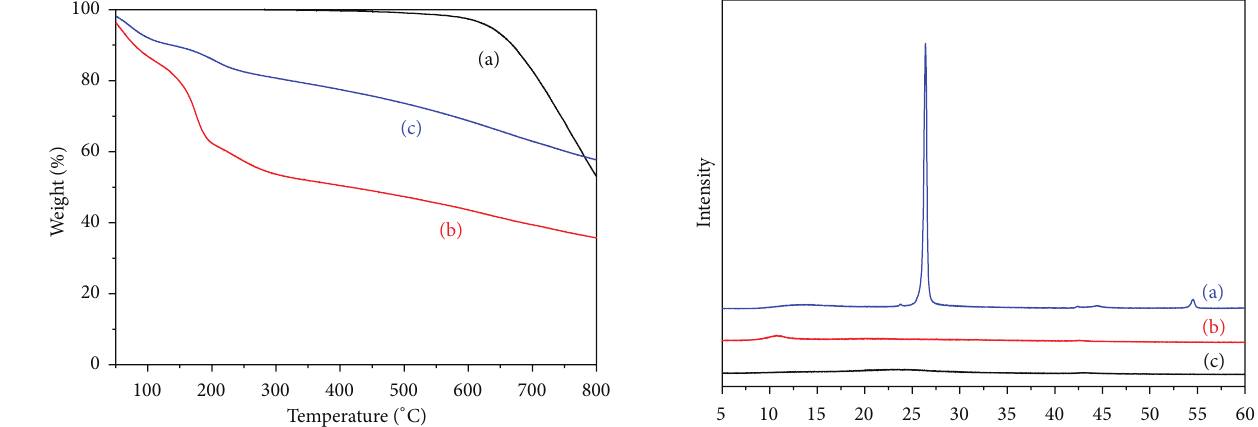
on the other hand, exhibits a new broad peak at 2𝜃 = 23.50 ∘ , corresponding to the d-spacing of 0.38 nm along the (002) orientation. This can be explained by the removal of oxygen functional groups, causing a decrease in d-spacing